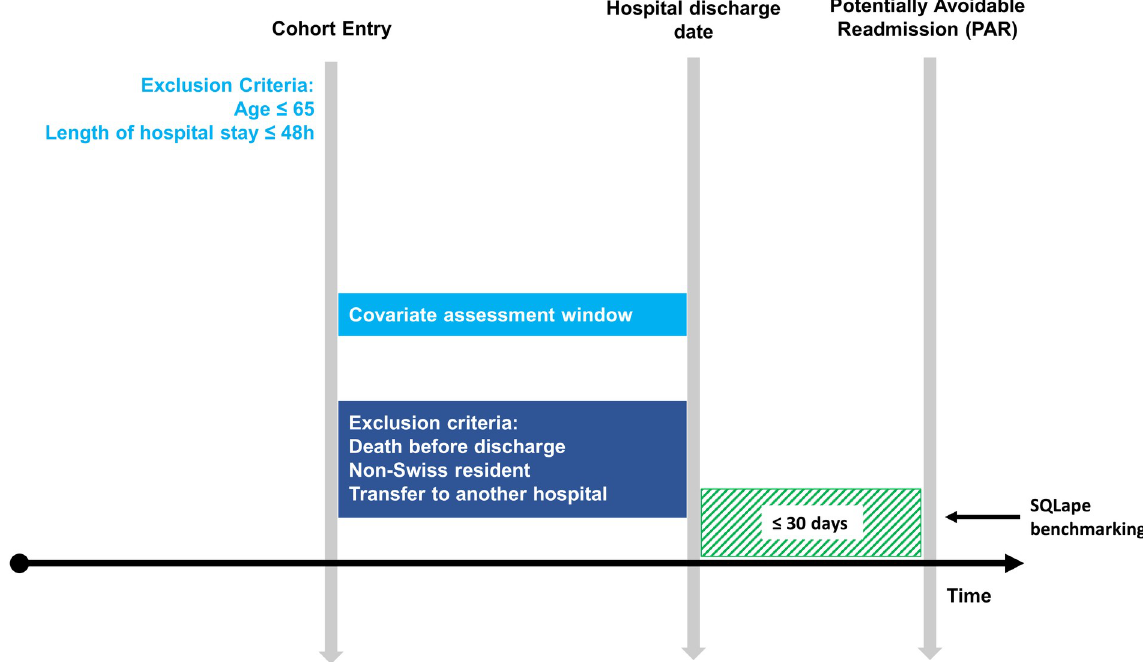
Fig 1. Cohort design of the external validation of the PAR Risk